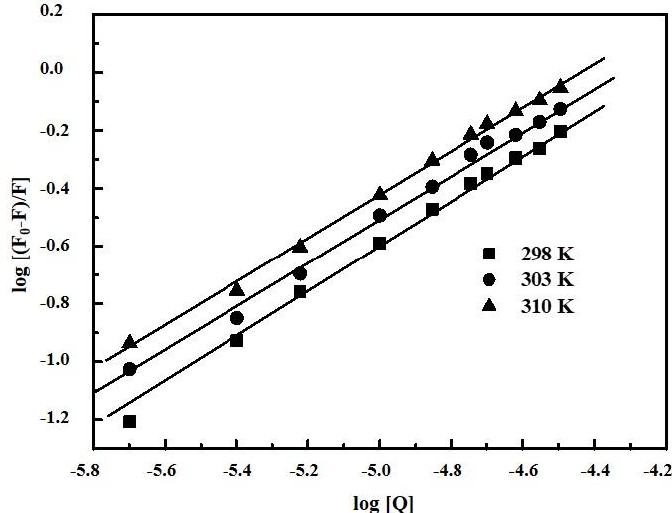
Figure 5. Hill plot for prothioconazole/bovine serum albumin (PTC/BSA) interaction. T = 298 K, 303 K and 310 K. Table 1. Binding and thermodynamic parameters for epoxiconazole/human serum albumin (EPX/HSA); epoxiconazole/bovine serum albumin (EPX/BSA) and prothioconazole/human serum albumin (PTC/HSA); prothioconazole/bovine serum albumin (PTC/BSA) interactions.